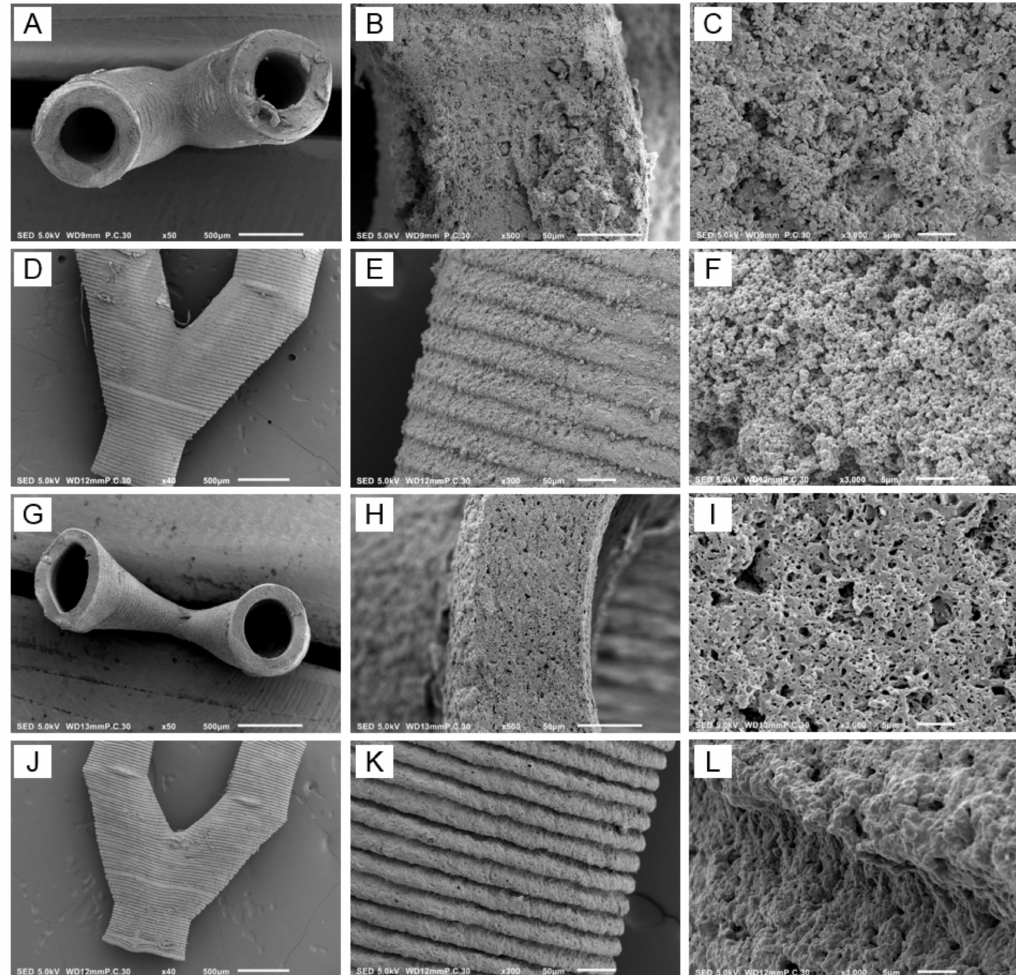
Figure 7. SEMimagesof( A – F )nonleachedand( G – L )leachedSLA-builtvascularstructuresafterextraction and postcuring. ( A – C ) and ( G – I ) show cross-sections, whereas ( D – F ) and ( J – L ) show the outer surfaces of the channels. Scale bar 500 µ m ( A , D , G , J ), scale bar 50 µ m ( B , E , H , K ), scale bar 5 µ m ( C , F , I , L